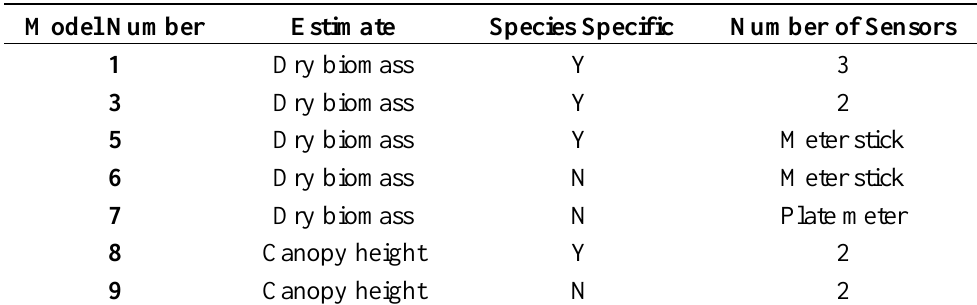
Table 2. Dry biomass estimation model label key for sensor and physical